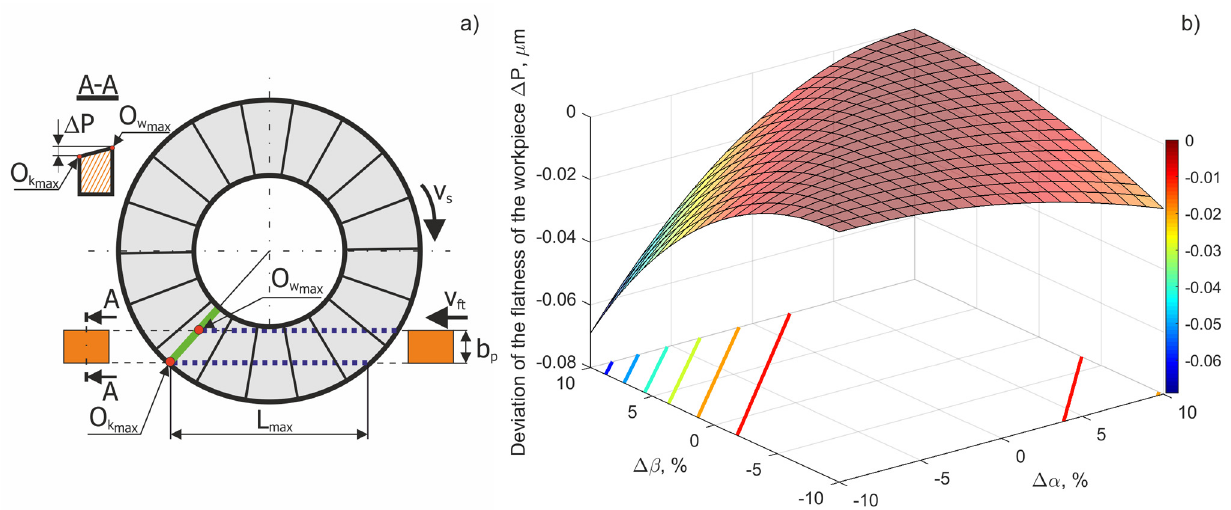
Figure 6. ( a ) Schematic for the surface flatness errors analysis of the workpiece following the micro- grinding process using a hyperboloid active surface. ( b ) Flatness errors of the workpiece Δ P as the result of Δα and Δ β values.